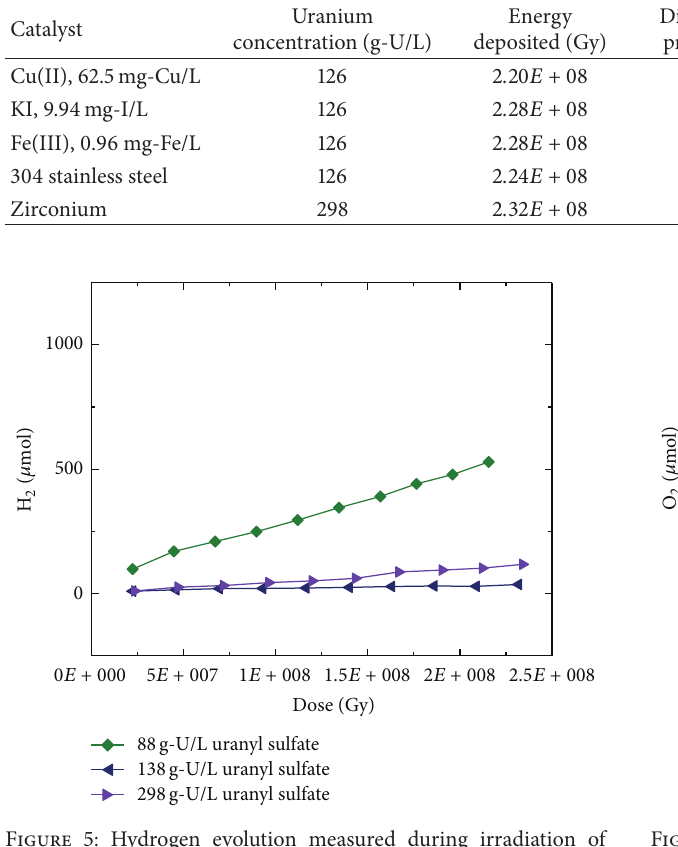
Table 7: Experimental data obtained from the irradiation of uranyl sulfate solutions in the presence of potential peroxide catalysts at the Van de Graaff.